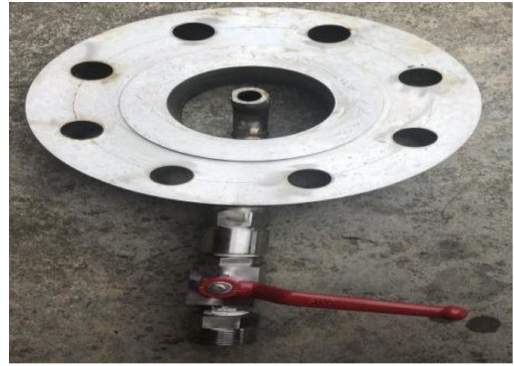
Figure 14. Particle filling